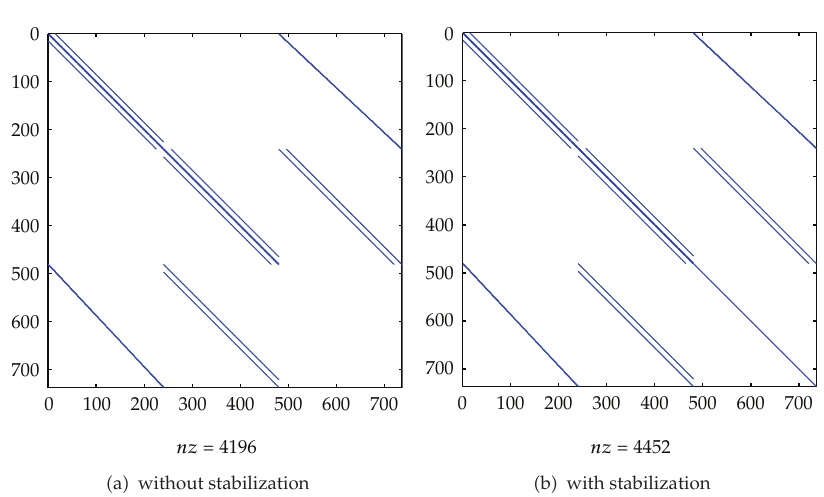
Figure 2: Sparsity patterns for di ff erent types of the 2D Oseen problem in convection form.